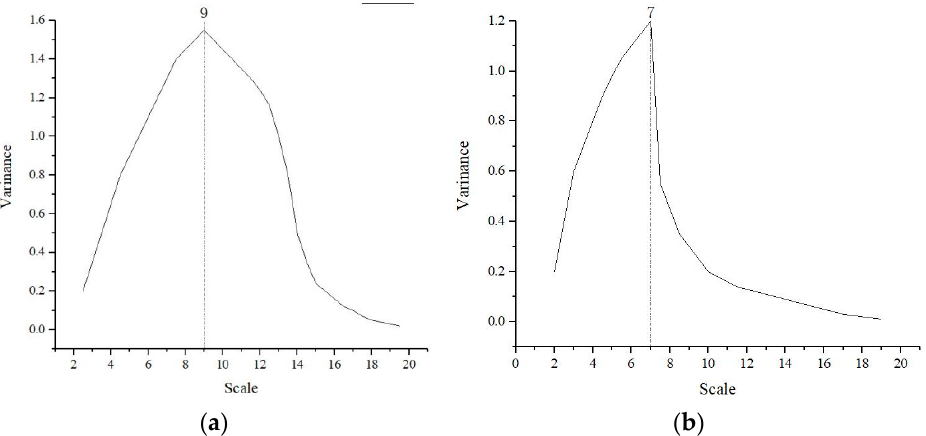
Figure 8. Variance diagram of wavelet coefficients (( a ) is the variance diagram of wavelet coefficients of NTL_POI, and ( b ) is the variance diagram of wavelet coefficients of NTL_POI_TMG).